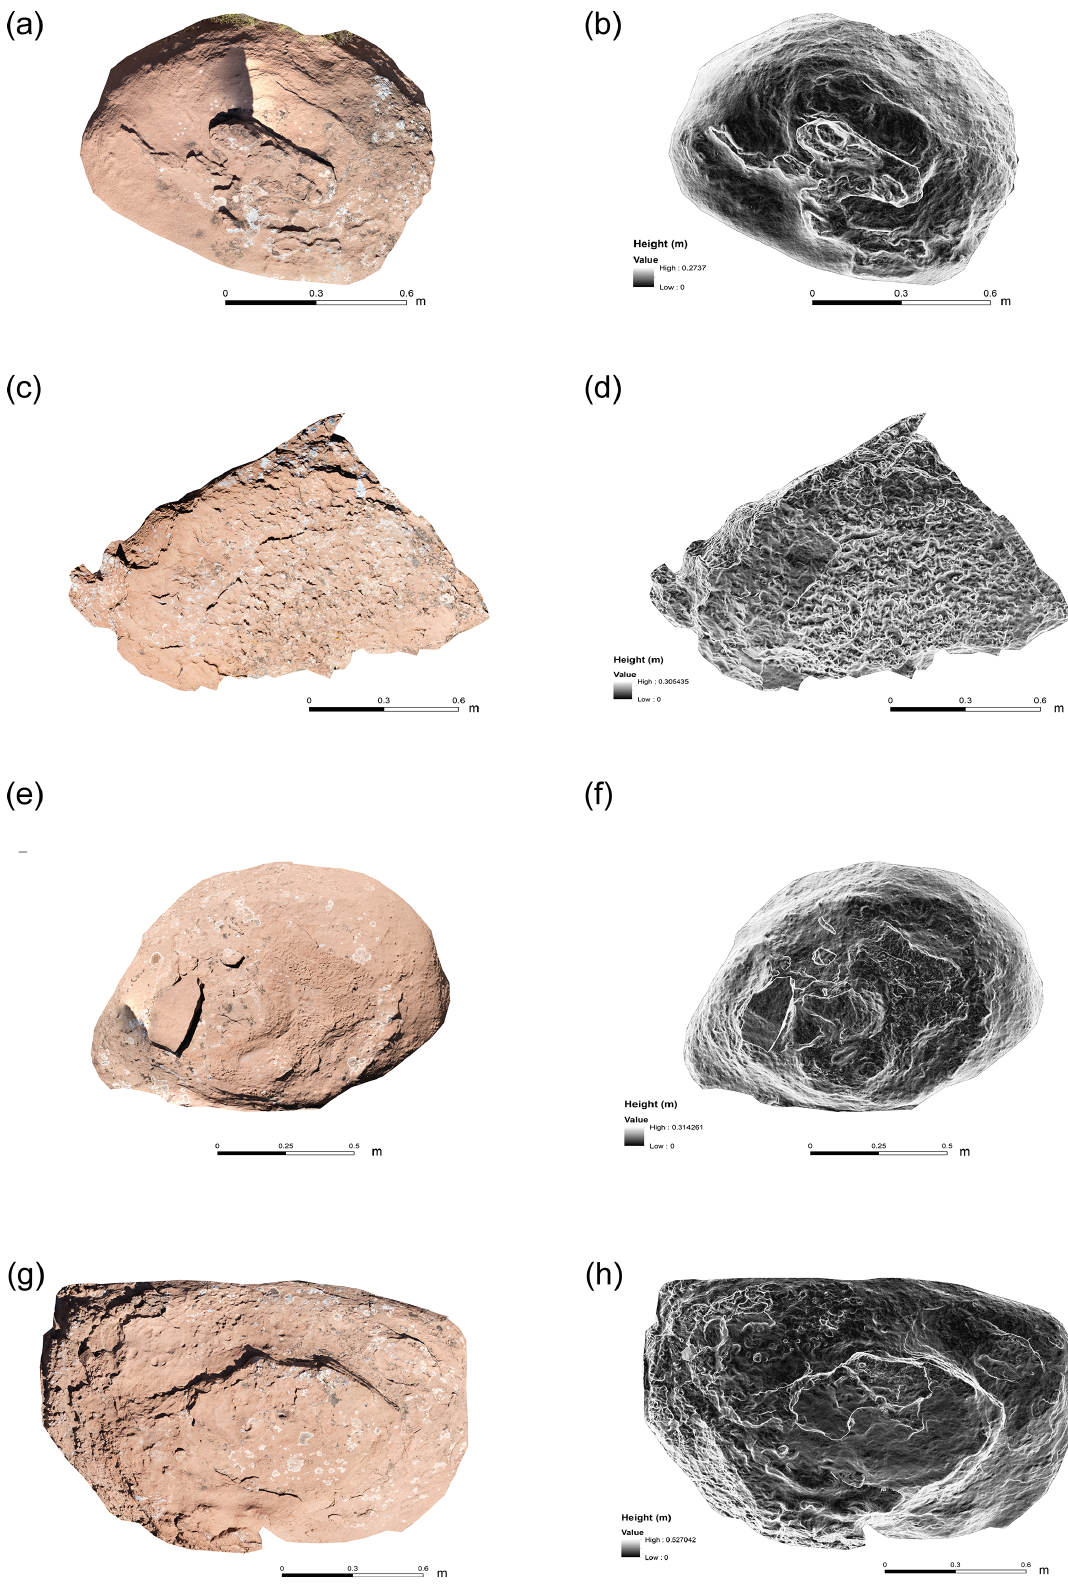
Figure 9. Orthophotos and DEMs of Moenkopi outcrops. (a, b) Boulder S2-M2. (c, d) Boulder S2-M5. (e, f) Boulder S2-M4. (g, h) Boulder